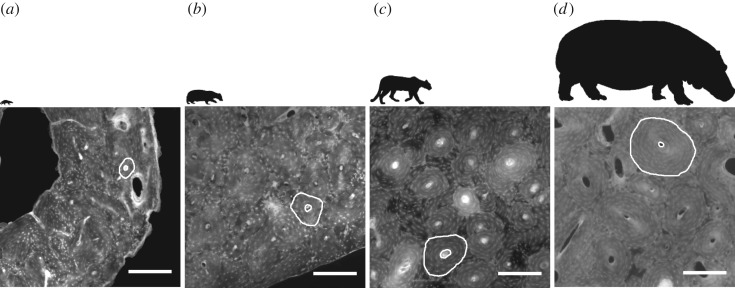
Close-ups of the bone cortex in four specimens with silhouettes reflecting the size differences above. (a) Banded mongoose, (b) European badger, (c) puma, (d) common hippopotamus (all scale bars 0.25 mm). Images © The Royal College of Surgeons, and reproduced here with their kind permission.